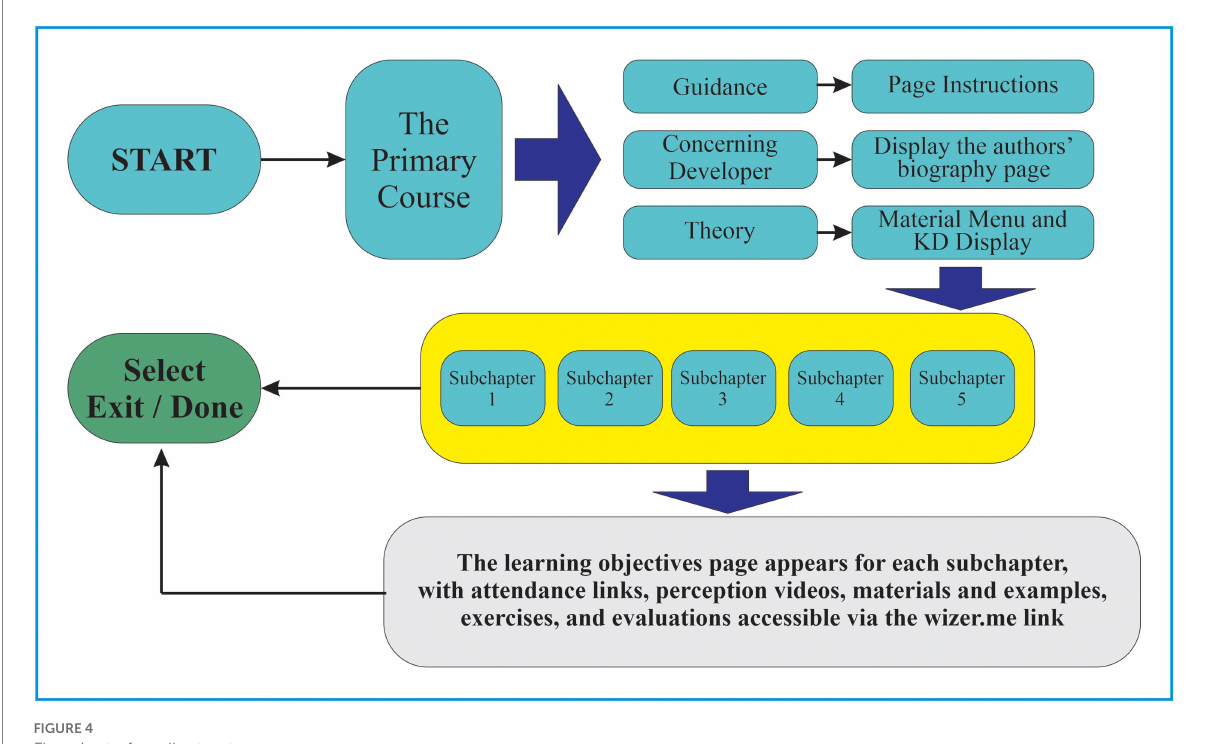
FIGURE 4 Flowchart of media